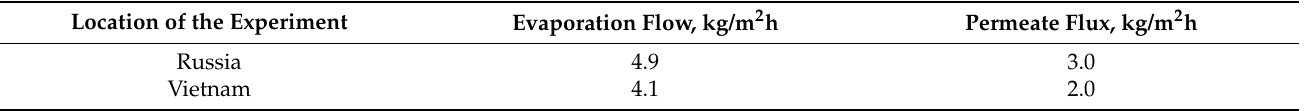
Table 2. The performance of FD-PC modules depends on the conditions of the experiment. Heating treated solution − 0.17 kg/min.